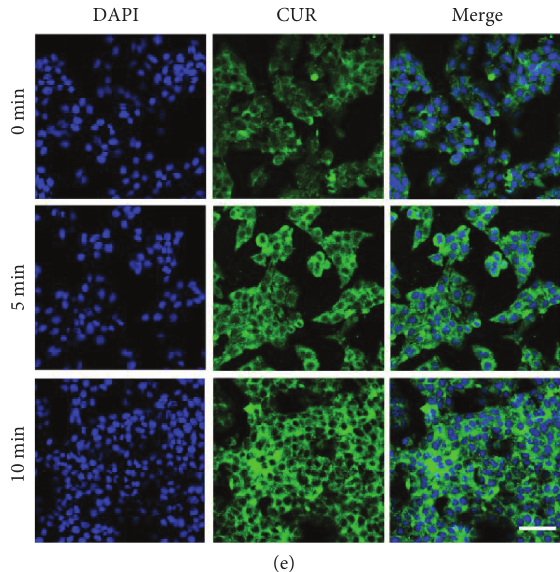
Figure 4: (a) Immunocytochemical staining and (b) protein level of EGFR expression in LO2 cells, HeLa cells, and A549 cells. Scale bar � 50 µ m. (c) FL images of A549 cells after 4h of incubation with free ICG, ICG-LPs, GE11-ICG-LPs, and GE11-ICG-LPs with free GE11 peptide or anti-EGFR antibody blocking. DAPI (blue) counterstains cell nuclei. Scale bar � 50 µ m. (d) The semiquantitative analysis of fluorescence intensity in (c) was determined by ‘Image J’ software. Data are expressed as mean ± SD ( n � 3). (e) FL images of A549 cells incubated with GE11-CUR/ICG-LPs after laser irradiation (1W · cm − 2 ) for different times. Scale bar � 50 µ